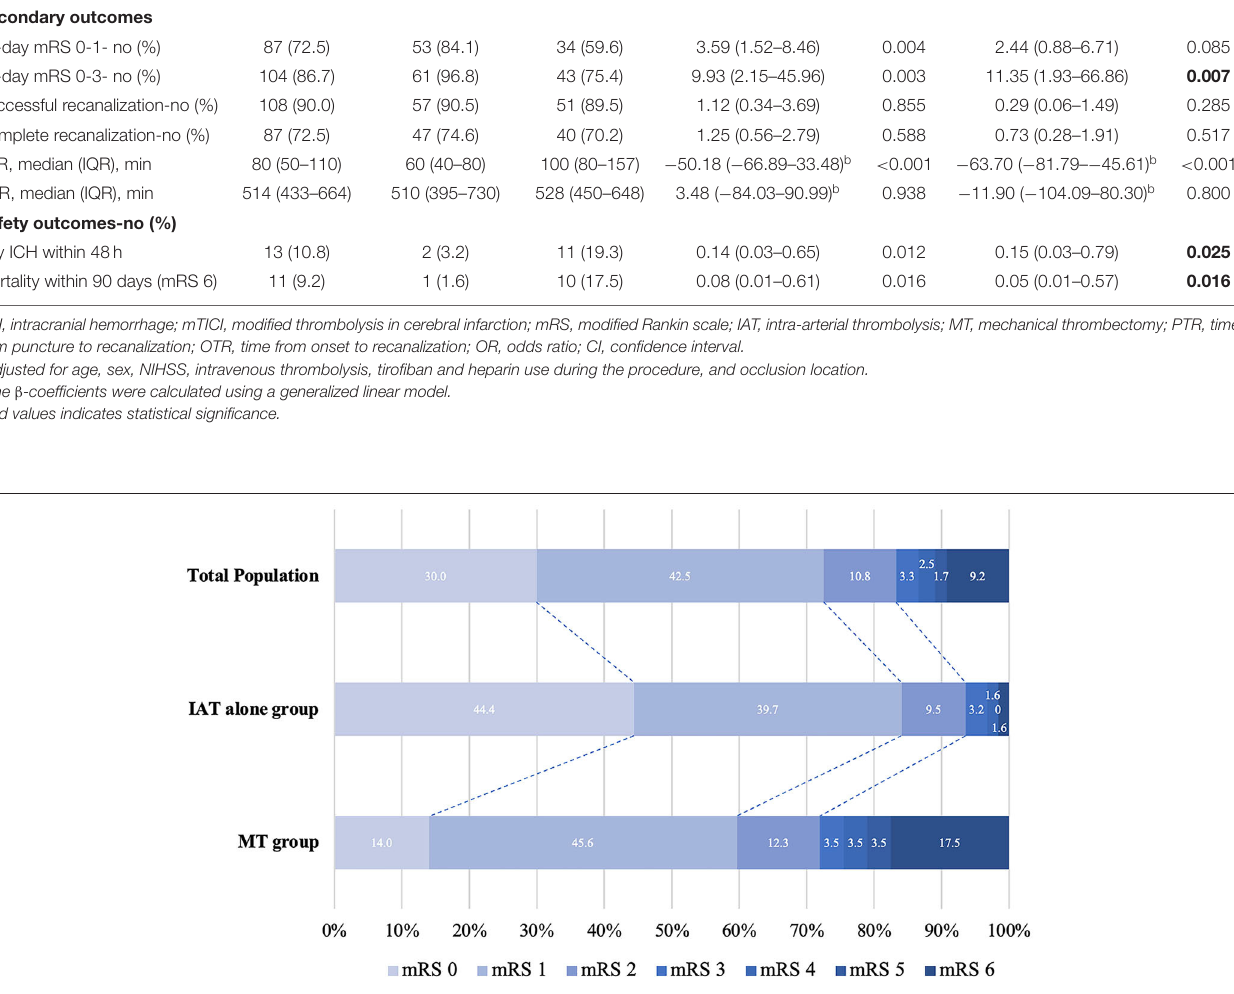
Frontiers in Neurology |